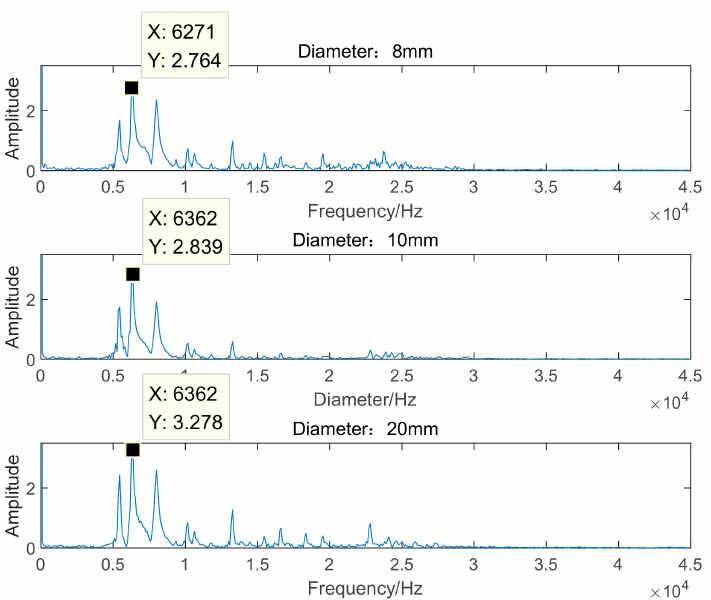
Figure 10. Time-domain impact characteristic curves of steel balls with different diameters.